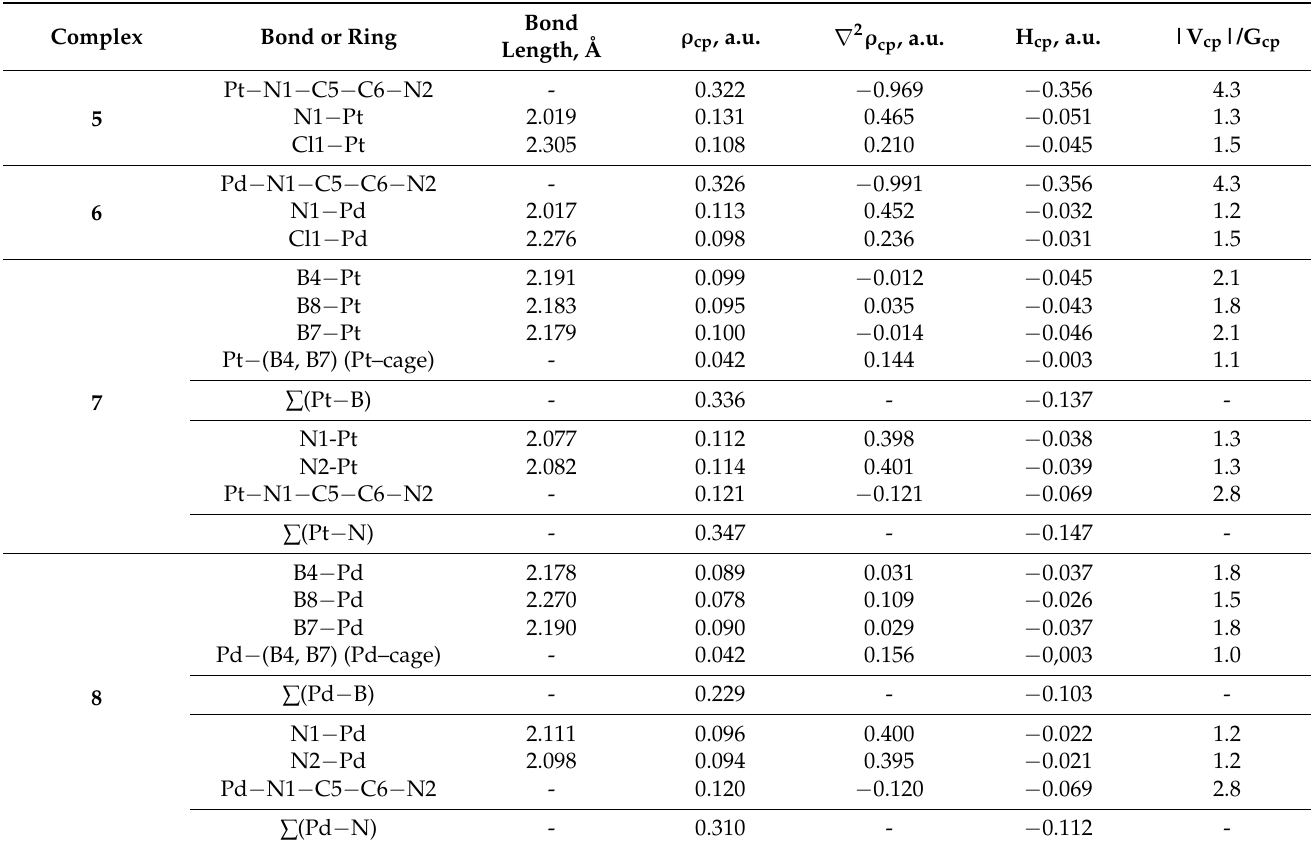
Table 1. Comparison of selected bond lengths and topological parameters of the bond critical points’ analyses: electron density ( ρ cp ), Laplacian of electron density ( ∇ 2 ρ cp ), total electron energy density (H cp ), and the ratio of the potential to kinetic energy densities |V cp |/G cp . The single crystal X-ray crystallography data of 5 – 8 were used as input, and the geometries were optimised at PBE0 D3BJ/ZORA-def2-TZVPP level of theory using DFT. Bond ρ cp , Length, Å